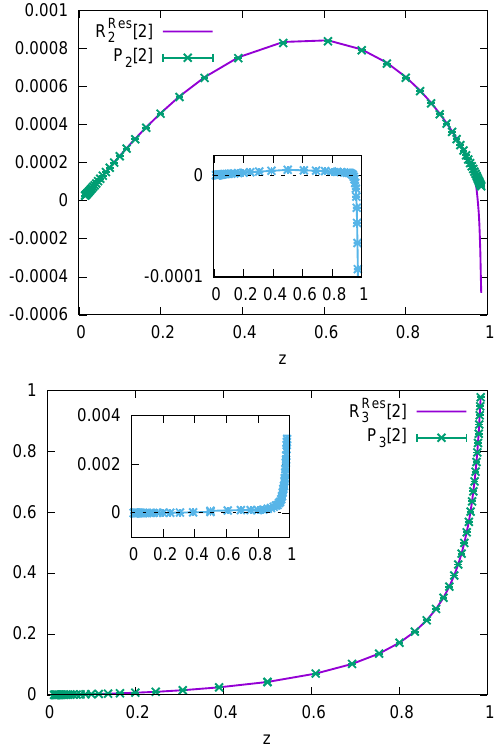
Figure 3.3: Residues of R functions of z . The insets give the differences R Res